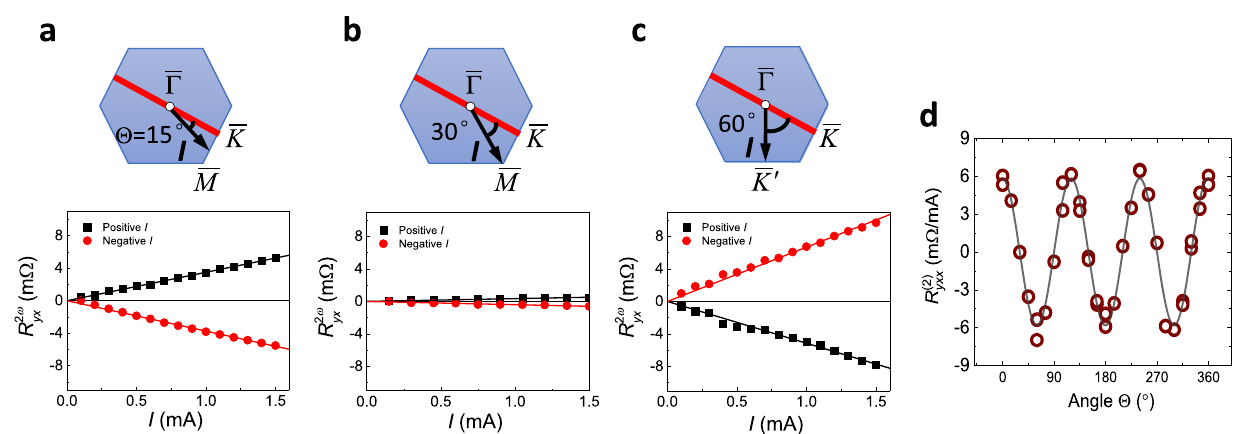
Fig. 3 Angular dependence of nonlinear transport in Bi 2 Se 3 . The second-harmonic transverse resistance versus current for three typical current injection angles at Θ = 15° ( a ), 30° ( b ), and 60° ( c ). Blue hexagon in the inset represents the FS of Bi 2 Se 3 . When current direction reverses, the second harmonic resistance changes sign in all current directions. The solid lines are linear fi ts to the data. d The slope of R 2 ω yx I ð Þ curves R 2 ð Þ yxx direction. The data in panels a – d were collected at T = 50